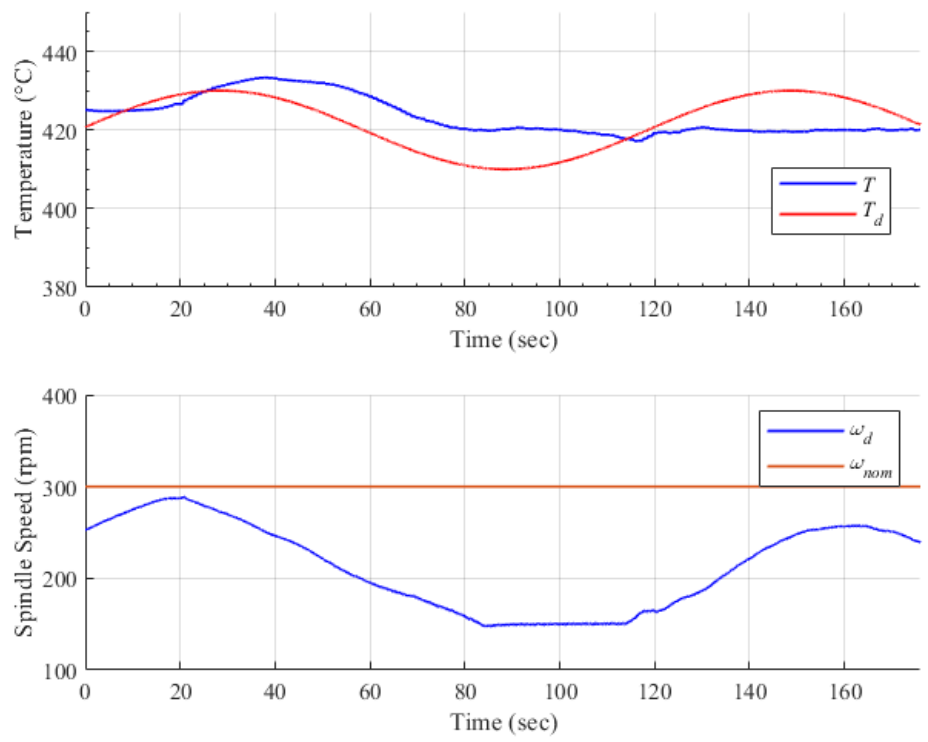
Figure 13. Protocol F. ( Top ) The desired versus measured temperature. A maximum error of 10.5 ◦ C occurs at t ≈ 150 s. ( Bottom ) The desired and nominal spindle speeds. Observe that the desired spindle speed ω d is saturated at ω min from t ≈ 85 s to t ≈ 115